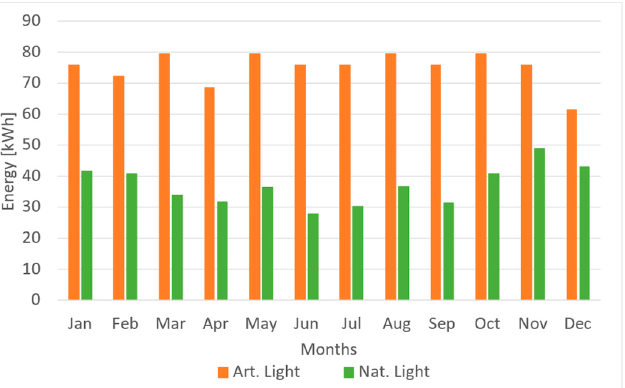
Figure 6. Monthly electric power consumption tendency for window facing south [12].